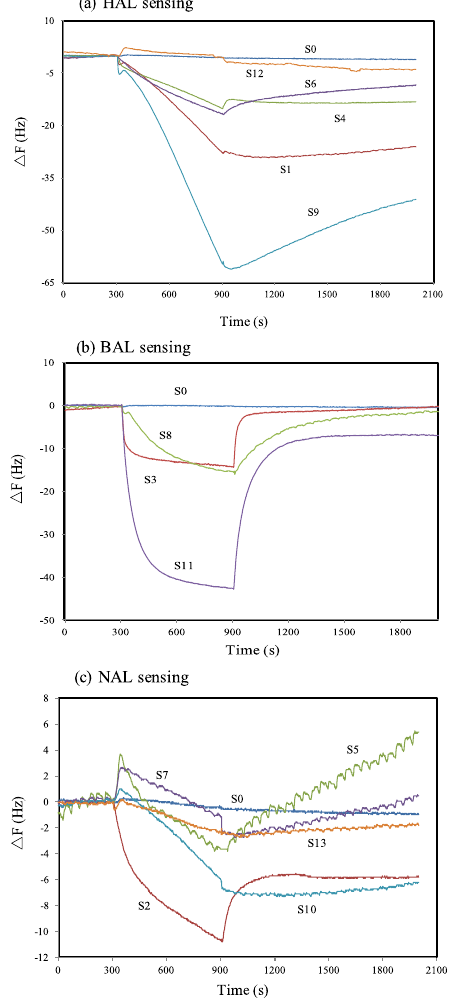
Figure 3. Response character of different MIP sensor channels on target vapors with a flow rate of 0.3 L/min: ( a ) HA-MIP on HAL, ( b ) BA-MIP on BAL and ( c ) NA-MIP on NAL.